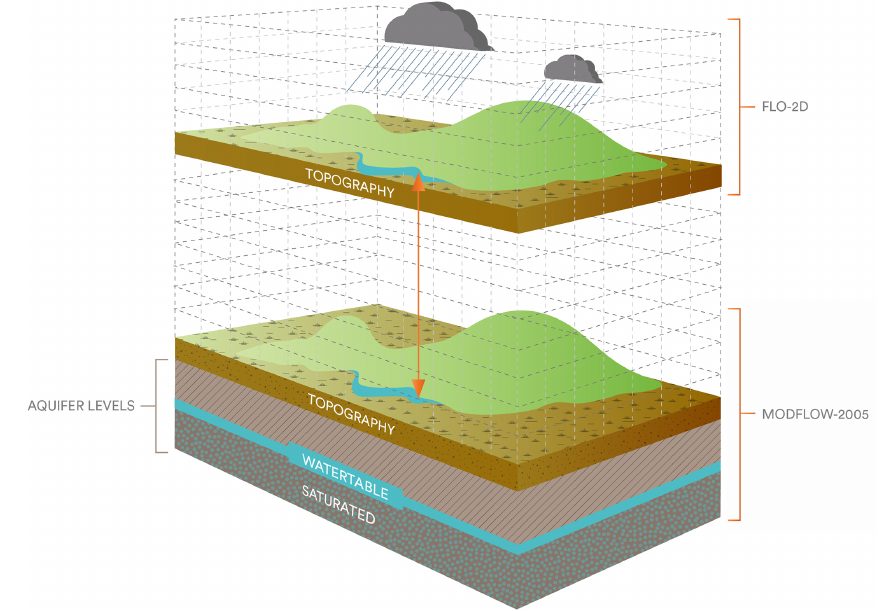
Figure 4. Spatial compatibility between FLO-2D and